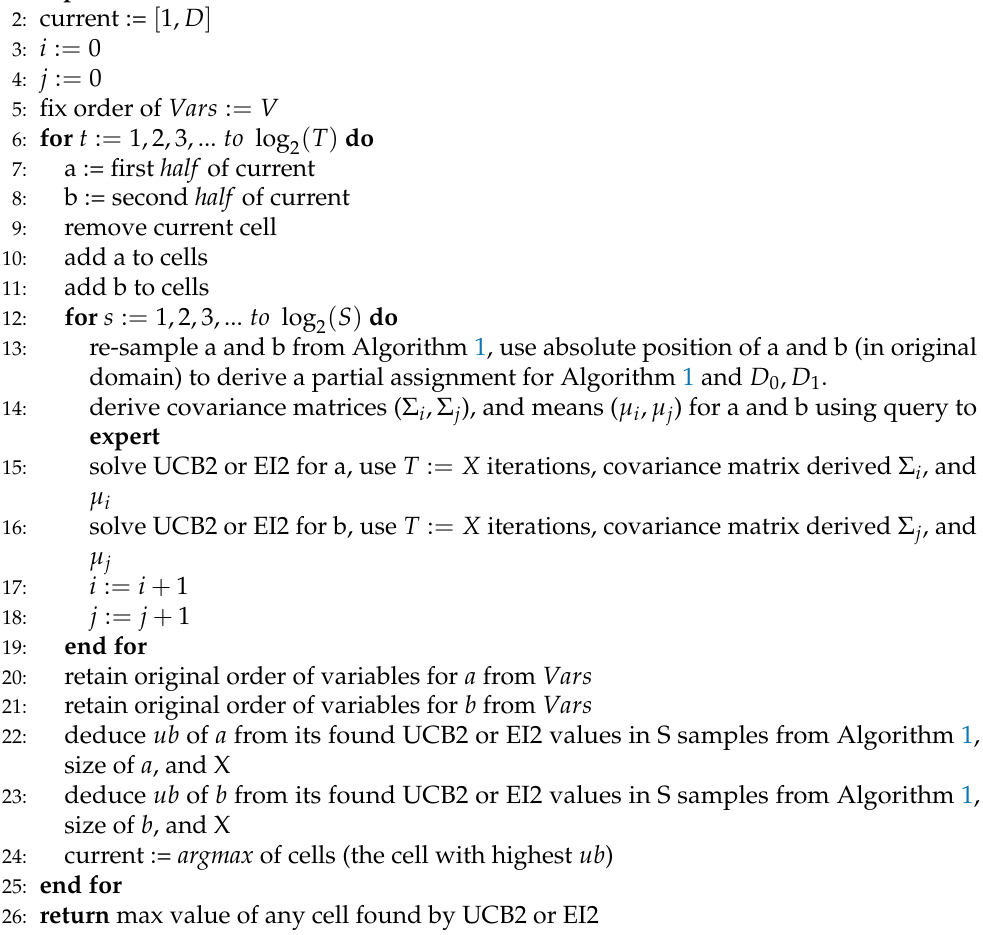
Algorithm 3 Bayesian optimization with expert